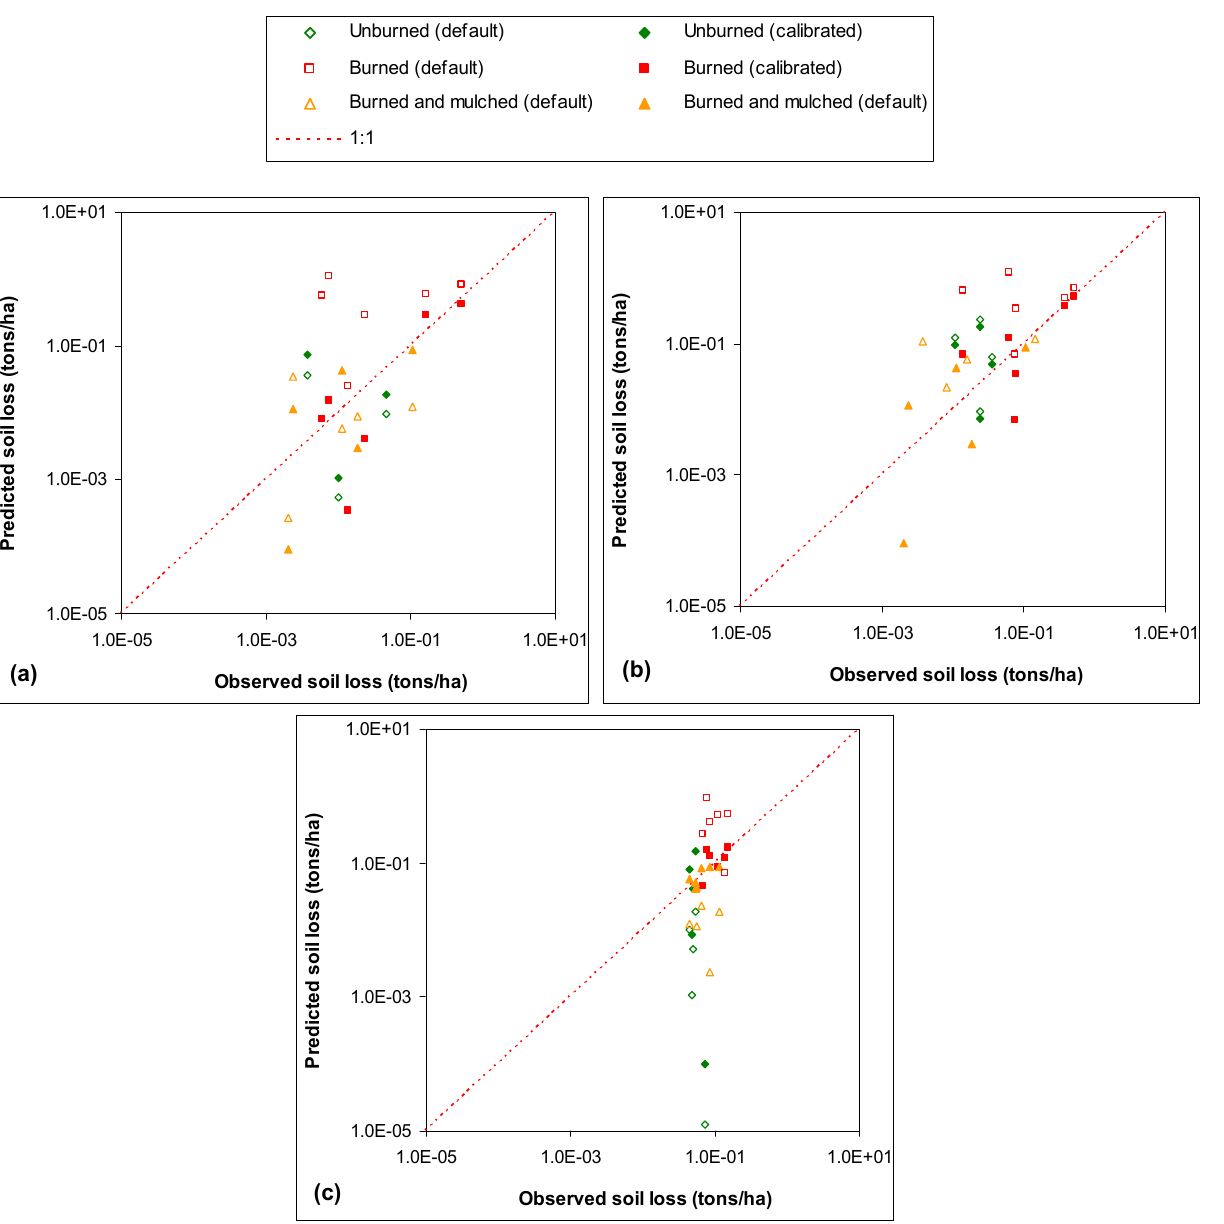
Figure 8. Scatter plots of soil losses observed in forest sites (( a ), pine; ( b ), chestnut; ( c ), oak) subject to prescribed fire and soil mulching with fern vs. predicted using the USLE-M model. Values are reported on logarithmic scales.